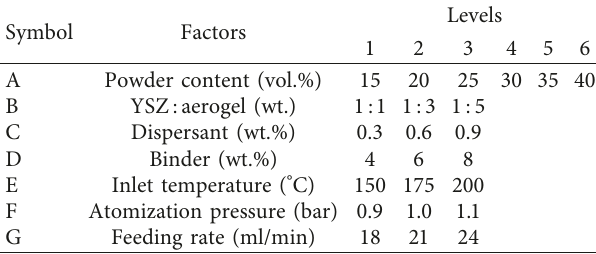
Table 1: Modified L18 Taguchi